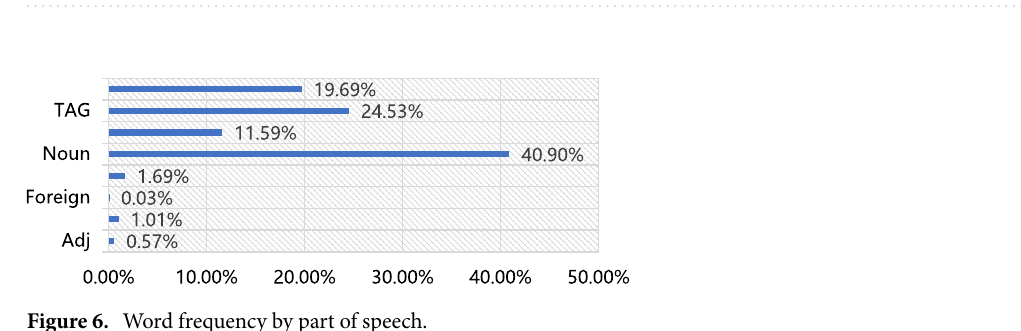
Figure 5. Descriptive statistics of words. ( a ) Term frequency (TF) distribution, ( b ) Document frequency (DF) distribution.